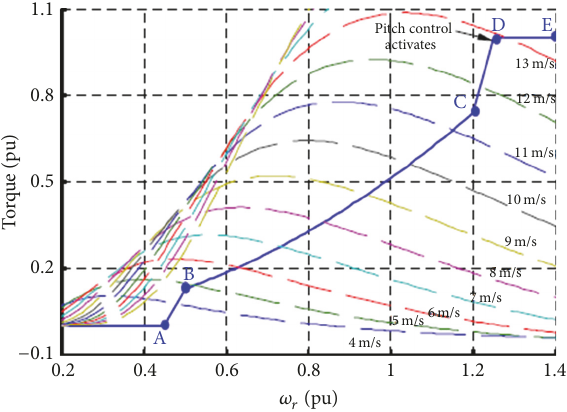
Figure 5: Turbine torque characteristics